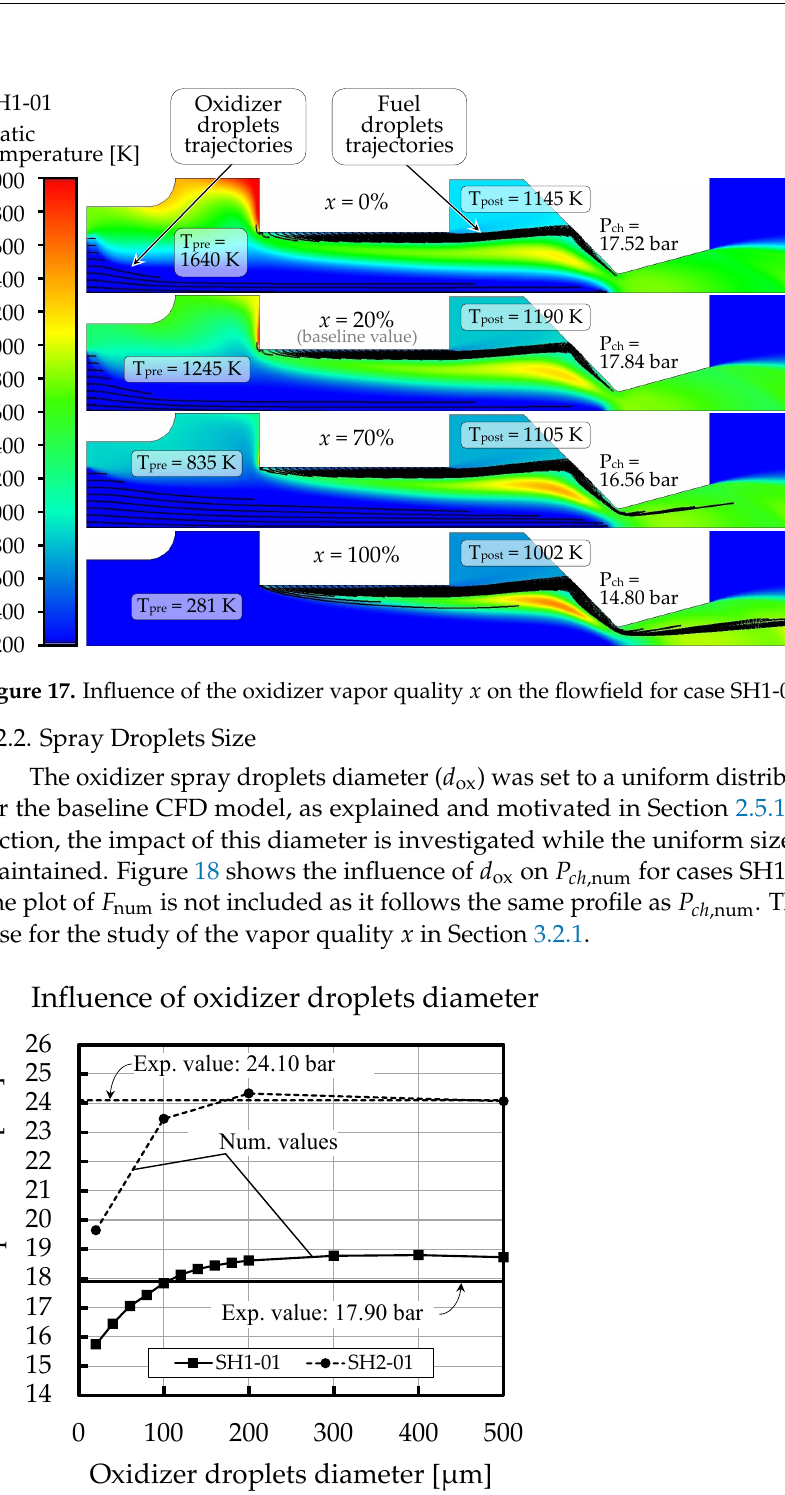
Figure 18. Impact of the oxidizer droplets diameter d ox on P ch ,num for the simulations of experiments SH1-01 and